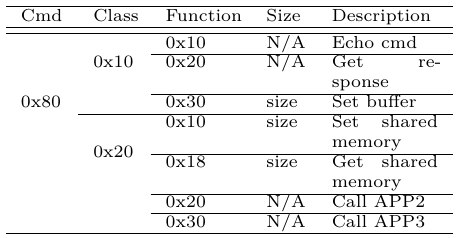
Table 8: Specification of commands for